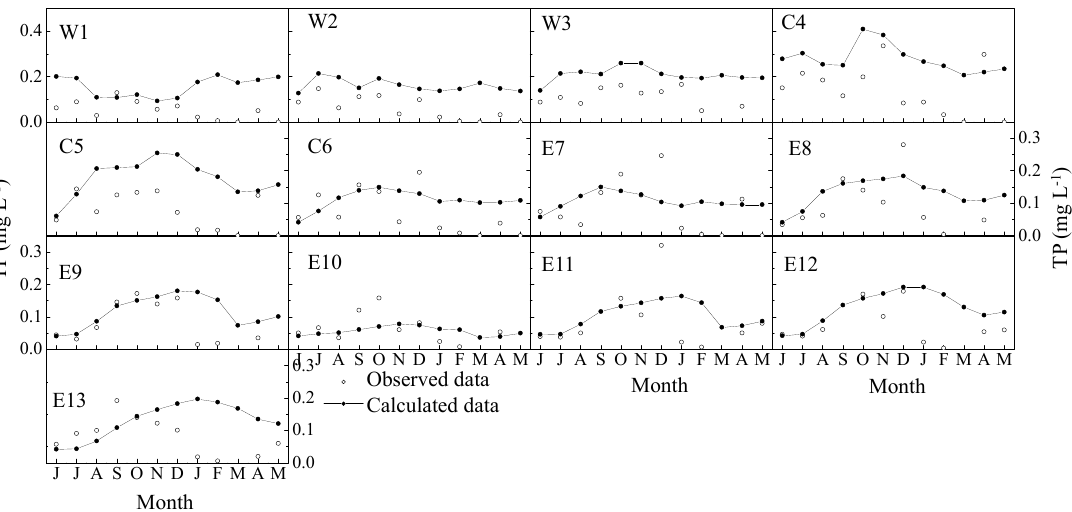
Figure 4. TP (mg L − 1 ) model (line + dots) and observed data (open dots) at 13 sites for June 2015 to May 2016.